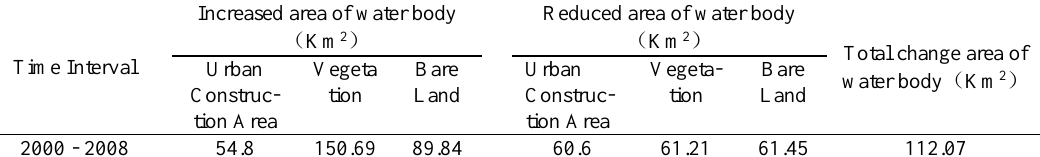
Table 12 Water area change from the year 2000 to 2008